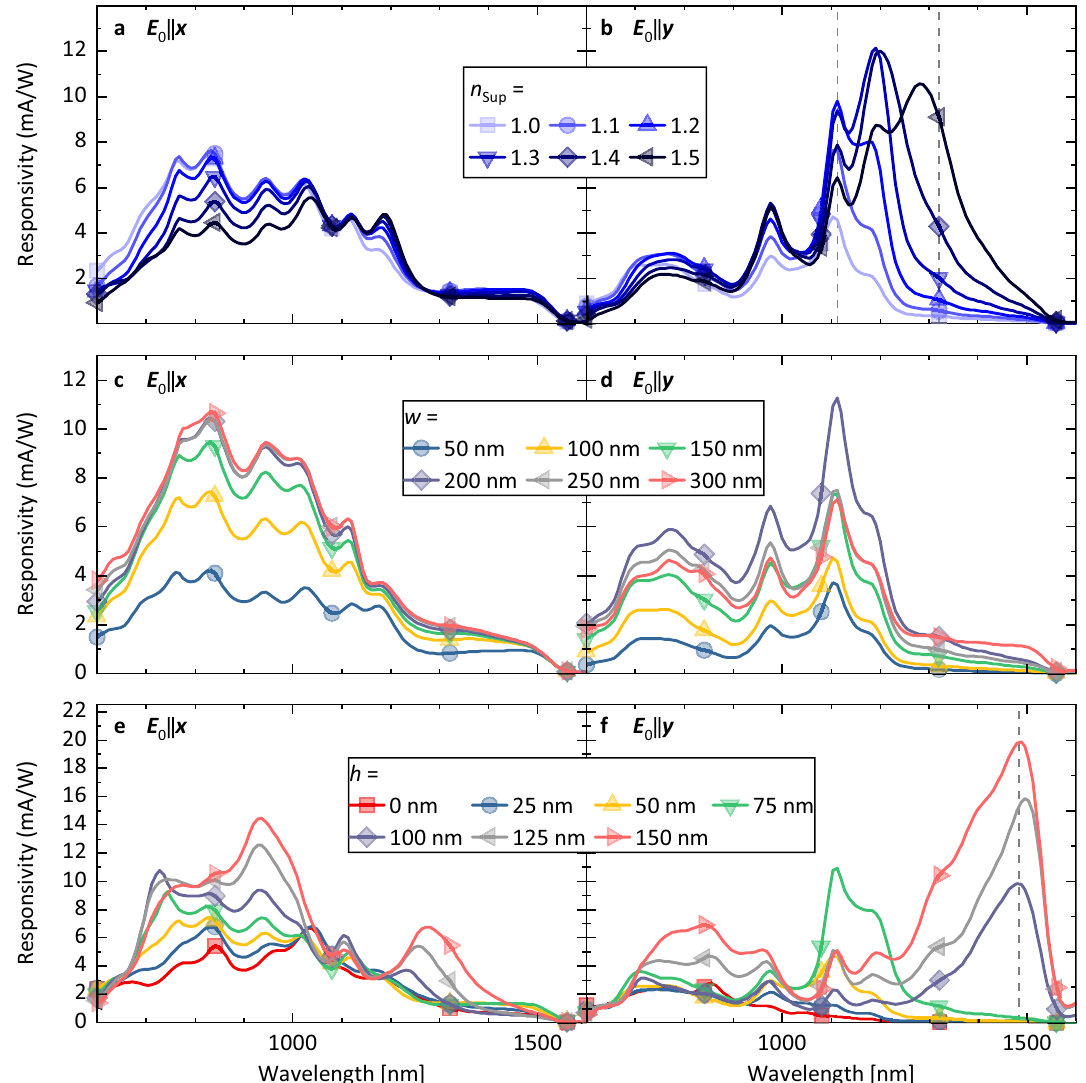
Figure 6. Simulated responsivities of a NP-PD device with a diameter of d NP = 300 nm (Fig. 1a, b) and illuminated with E 0 ‖ x and E 0 ‖ y using varying material and geometry parameters. Results are shown for ( a ) and ( b ) variations of the superstrate refractive index n sup at w = 100 nm and h = 50 nm, ( c ) and ( d ) variations of the NA geometry parameter w at h = 50 nm and n sup = 1.0, ( e ) and ( f ) variations of the geometry parameter h at w = 100 nm and n sup = 1.0. Field profiles E (x,y,z) for wavelengths indicated by the dashed lines are shown in the supplementary